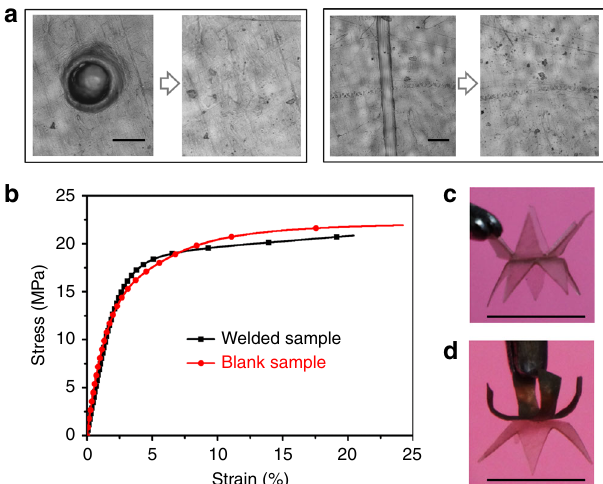
Fig. 6 Solvent-induced welding and healing of epoxy vitrimer. a Solvent triggered healing of vitrimer with a needle pierced hole (left panel) and a narrow cut (right panel). Scale bars: 100 µ m. b The lap shear tests of welded samples. The stress and strain were measured while the sample was stretched at a ramp force of 0.5 N/min. c Welding to a more complicated structure. Scale bar: 1 cm. d Welding two 3D structures with different components to a more complicated structure. Scale bar: 1 cm